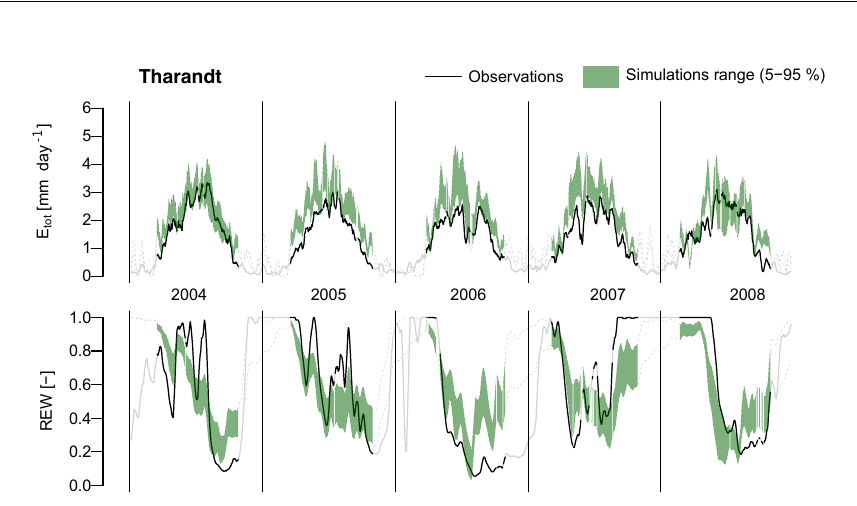
Figure B2. Time series of total evaporation E tot and relative extractable water REW for the validation period (2004–2008) at Tharandt, comparing the observations with simulations conducted using the parameter sets selected after calibration (see Table 3). The solid line shows the observations, and the dotted lines show the 5 and 95% quantiles of the simulations at each time step. For clarity, the time series are presented here as 10-day moving averages, while the simulations were done with a half-hourly time